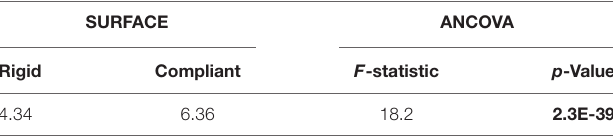
TABLE 1D | Linear regression results on intercept (N − 1 ) in total (pooled) for each surface and ANCOVA results across both surfaces.